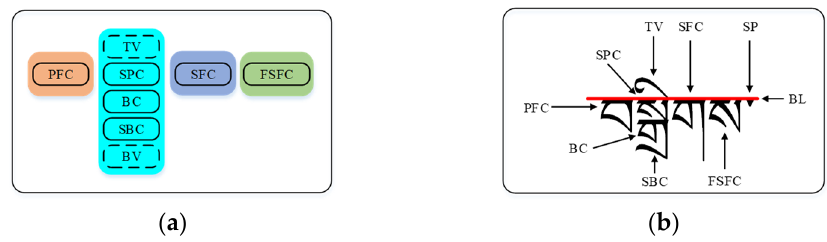
Figure 3. Syllable structure in Tibetan: ( a ) schematic diagram of syllable structure in Tibetan; ( b ) example of syllable structure in Tibetan. Table 1. Corresponding examples Tibetan characters and Unicode coding.